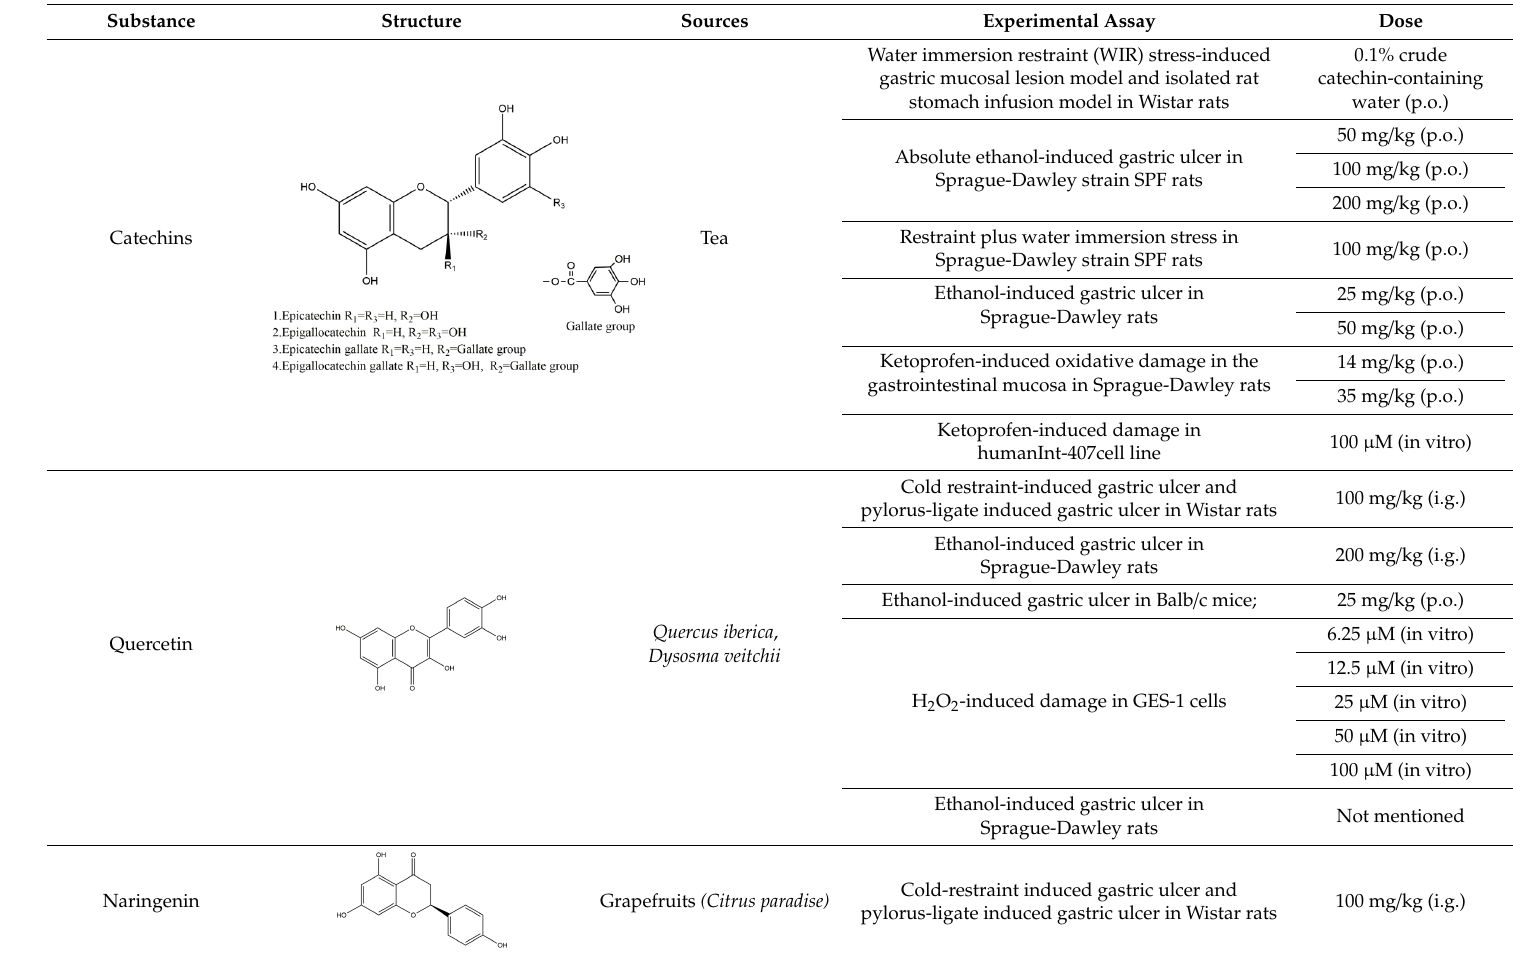
Table 1. Studies on the prevention of peptic ulcer by flavonoids.